Question: How would you classify this visualization?
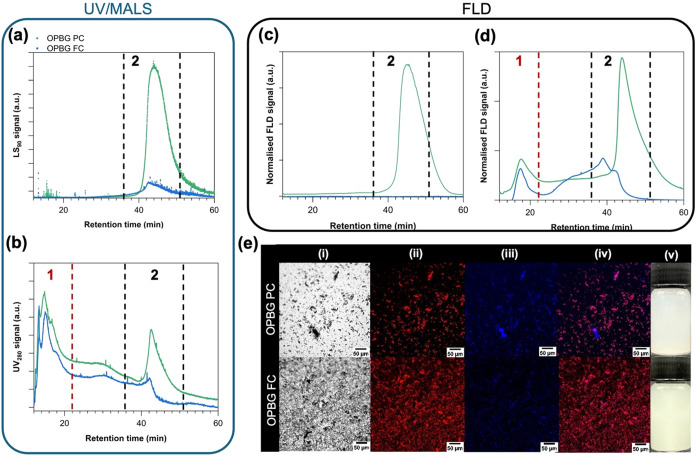
Answer: scatter